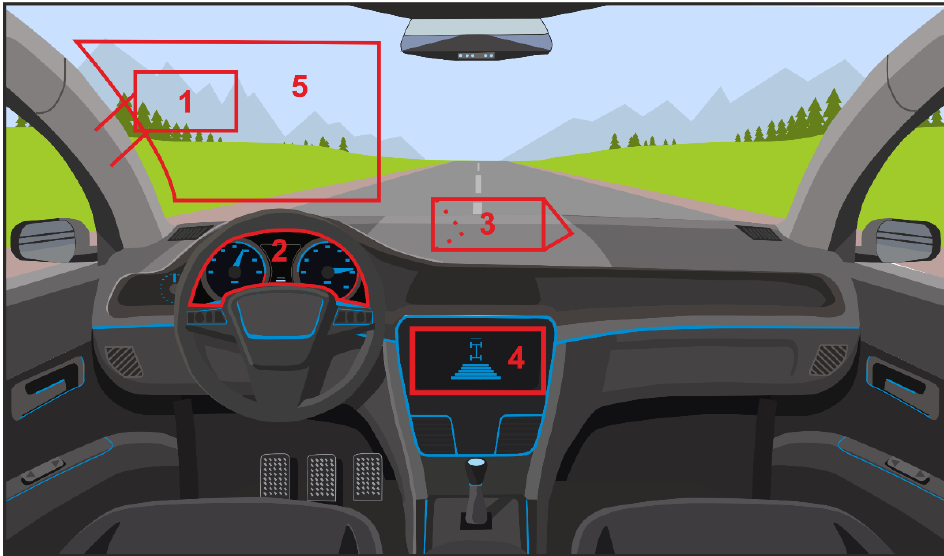
Figure 6. Possible placements for the navigation interface (based on a [53] image). Table 2. Current and recommended placements in percentage distribution.